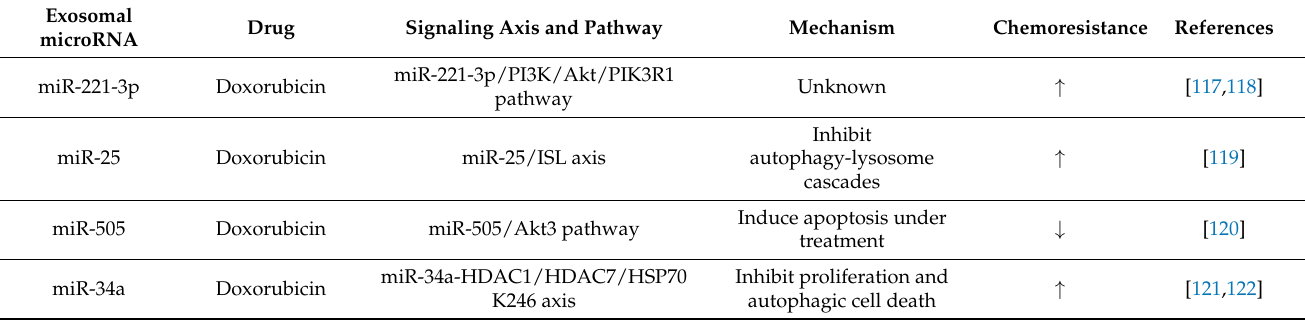
Table 1. Exosomal microRNAs take part in